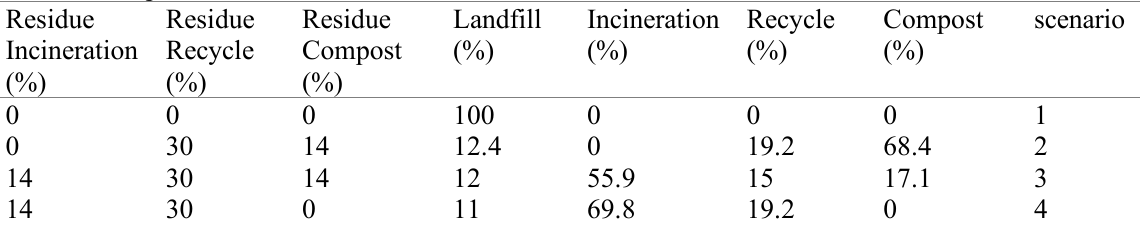
Figure1 . System boundary Table 2 . Disposal solid waste